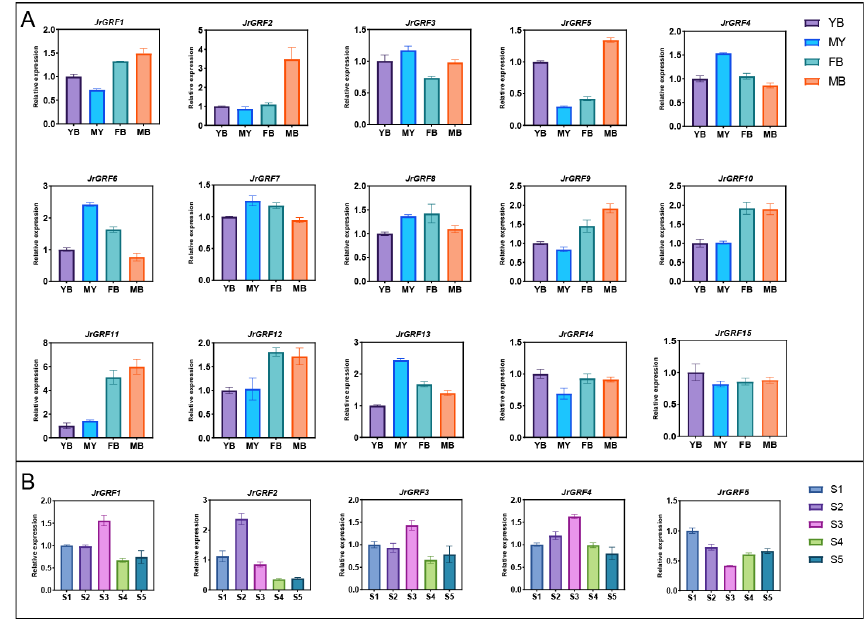
Figure 9. Relative expression of JrGRF in different tissues and stages of female flower bud differentiation. ( A ) The expression pattern of JrGRFs in different tissues of walnut. ( B ) Expression pattern of JrGRFs in female flower bud differentiation of walnut.